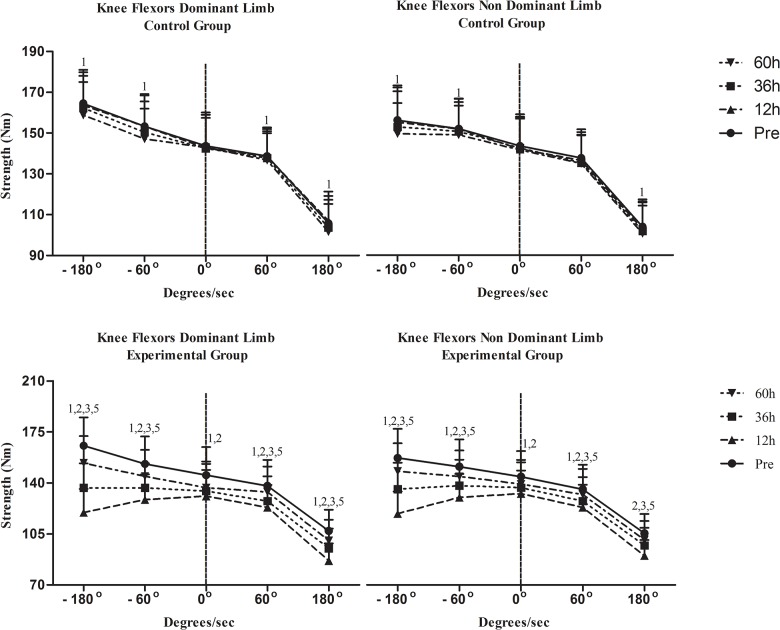
Changes of strength performance of knee flexors in response to a football match.h, hours; 1Significant difference with baseline; 2significant difference between groups; 3significant difference between dominant and non-dominant limb at corresponding time; 4greater decline in functional ration compared to conventional ratio at corresponding time;5greater decline at 180°/s compared to that at 60°/s at corresponding time.